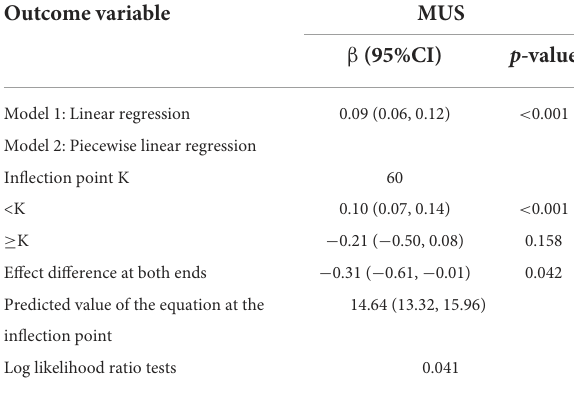
TABLE 3 Threshold effect analysis of age and